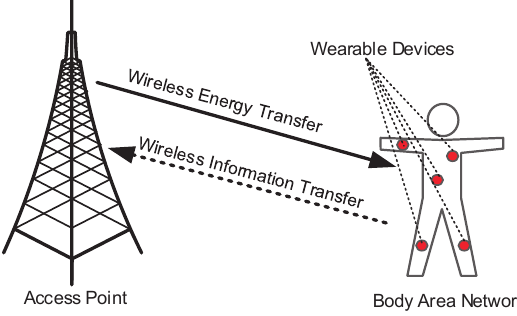
Figure 1. Energy harvesting-based body area